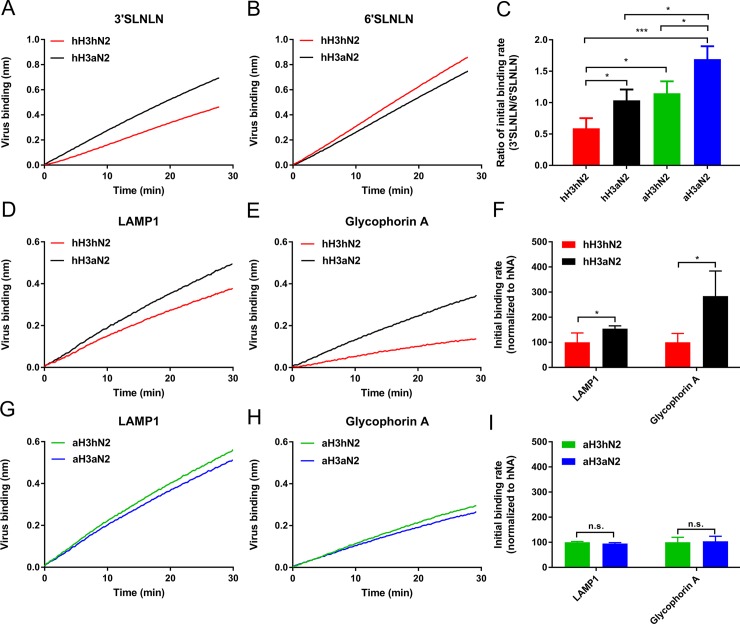
Binding of H3N2 viruses to LAMP1 and glycophorin.A. Identical number of hH3hN2 and hH3aN2 virus particles (determined using Nanoparticle Tracking Analysis; Nanosight NS300; S10 Fig) were analysed for their ability to bind 3’SLNLN (A), 6’SLNLN (B), LAMP1 (D) and glycophorin A (E) in the presence of OC using BLI. (C) Initial binding rates (vobs = dB/dT) were determined as described previously [37] and ratios (3’SLNLN/6’SLNLN) were determined and graphed normalized to hH3aN2. Identical number of aH3hN2 and aH3aN2 virus particles were analysed for their ability to bind LAMP1 (G) and glycophorin A (H) in the presence of OC using BLI. Initial binding rates of the different virus-receptor combinations were determined and normalized to either hH3hN2 or aH3hN2 (F and I). Experiments were performed three times and representative experiments are shown (A, B, D, E, G, H). Mean values of these three independent experiments are shown (C, F, I). Standard deviations are indicated. Stars depict P values calculated using one-way ANOVA (C) or an unpaired two-tailed Student t test (F, I) (*, P<0.05; ***, P<0.001).